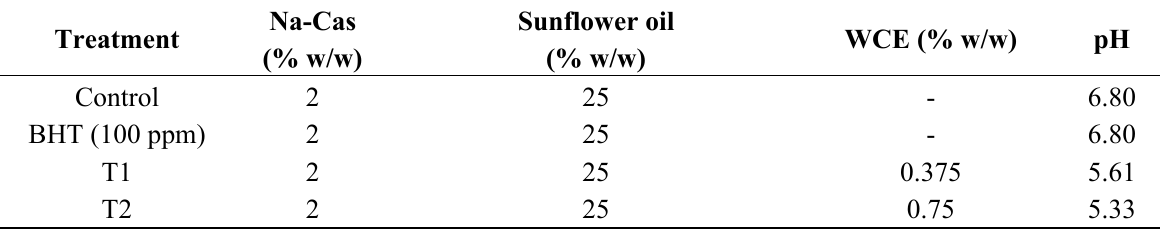
Table 3. Final composition and pH of control emulsions and emulsions containing BHT and whole cranberry extract (WCE) 1